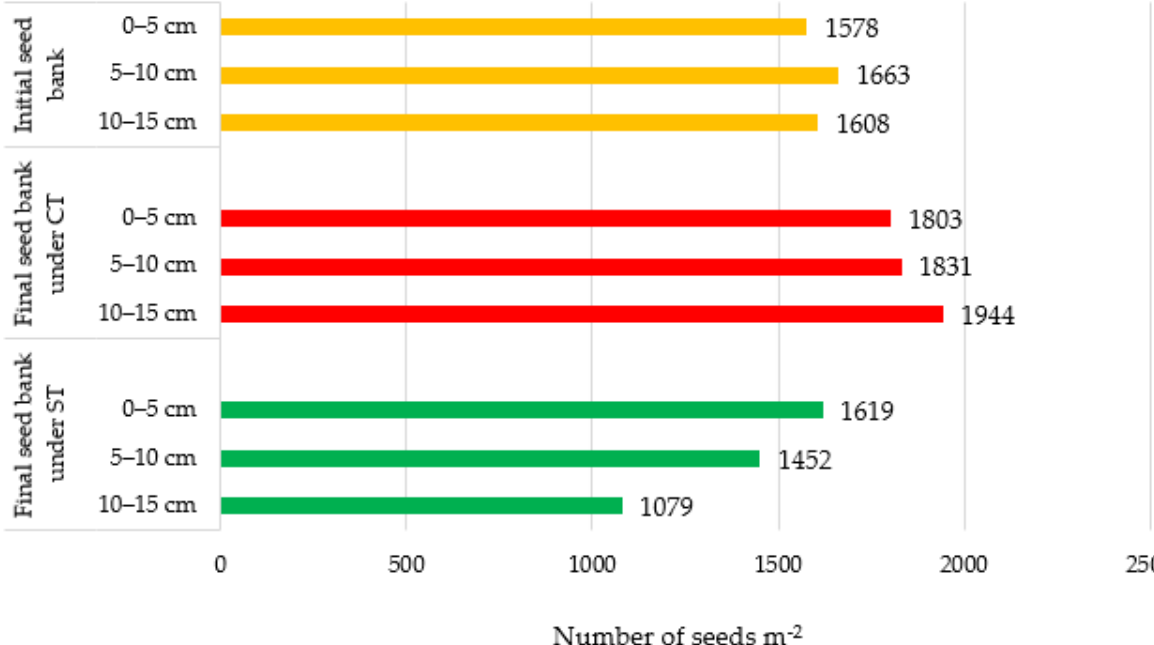
Figure 4. Vertical distribution of seeds at 0–5, 5–10, and 10–15 cm soil depth under different tillage (mean from two crop rotations).